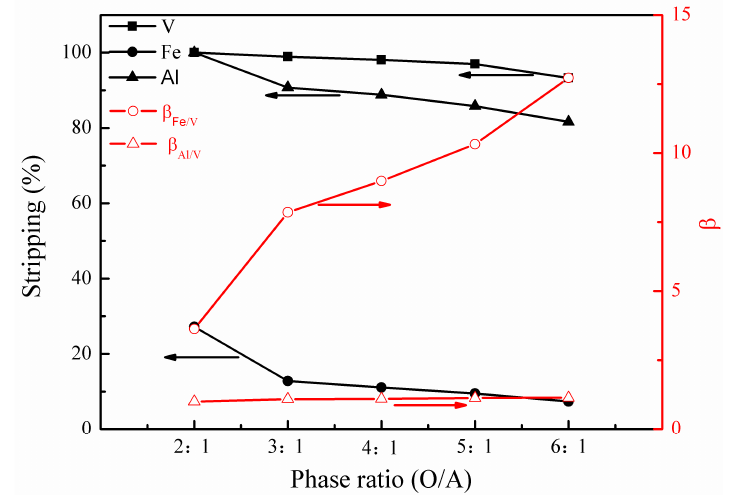
Figure 9. Effect of phase ratio (O/A) on the stripping percentages of V (IV), Fe, and Al, as well as on the separation factors β Fe/V and β Al/V .